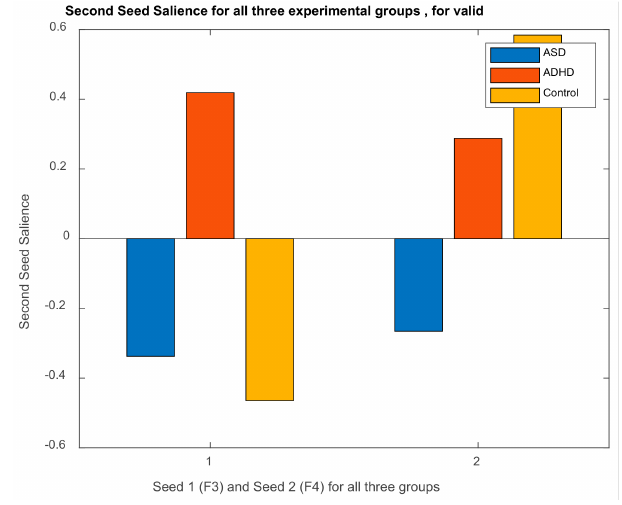
Figure 21. Plot of second seed salience vs. seeds 1 and 2 (MSE values at F3 and F4, respectively), for all groups, in the valid syllogism.